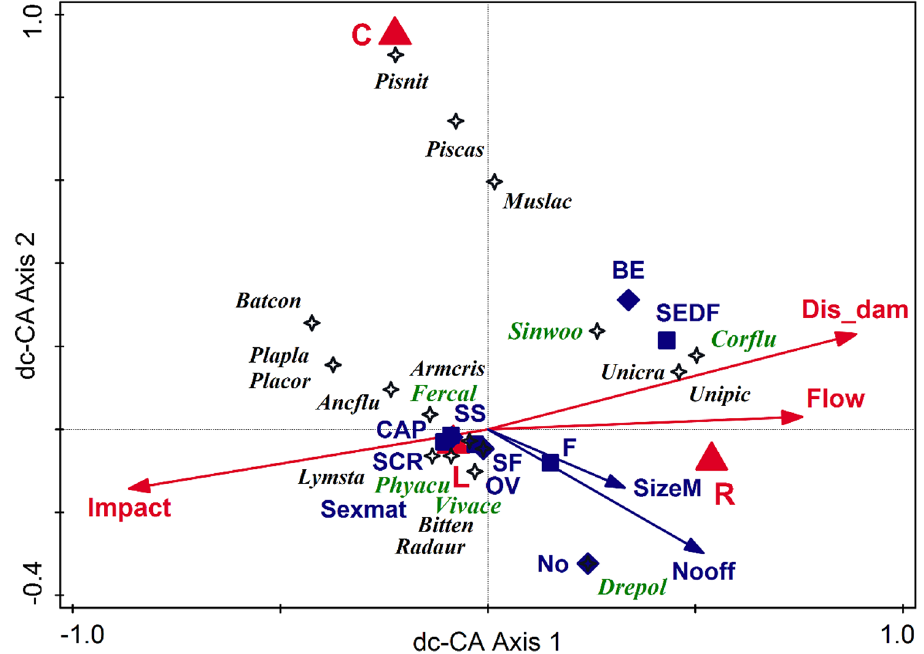
Figure 4. Double-constrained correspondence analysis (dc-CA) on species counts in 2020 (T3), with selected environmental predictors (in red: Dis_dam—distance to the nearest dam downstream; Flow—average water flowing conditions; Impact—human impact intensity; Habitat: C—canals, R—river, lotic sector, L—lake, lentic sector in reservoirs) and functional traits (in blue: SizeM—mean body size; Nooff—number of offspring; Sexmat—sexual maturity; Feeding type, as squares: SCR—scraper, SS—scraper and sediment, SF—scraper and filter, F—filter, SEDF—suspension and deposit feeder; Oviposition, as diamonds: OV—ovo-viviparity, CAP— capsule/eggmass, BE—parental care, juveniles in brood pouches of demibranchs, No—no oviposition, external fecundation). Species are coded by the first three letters of the genus and species names. Selected 18 species are depicted. The adjusted explained variation was 36.6%, the first axis accounts for 11.8% and the second for 10.4%. Native species have black labels, while the aliens (AIS) are written in